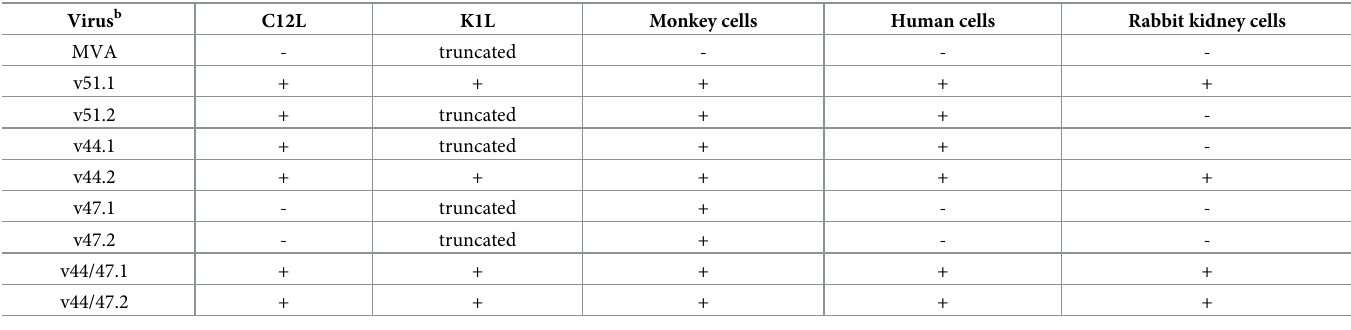
Table 1. Correlation of C12L and K1L with host range in human and rabbit cells a